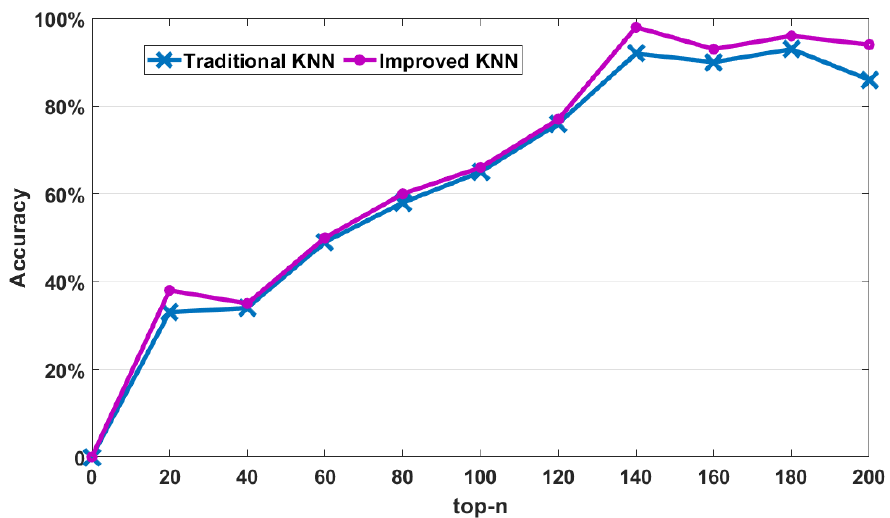
Figure 9. False alarm rate variation.